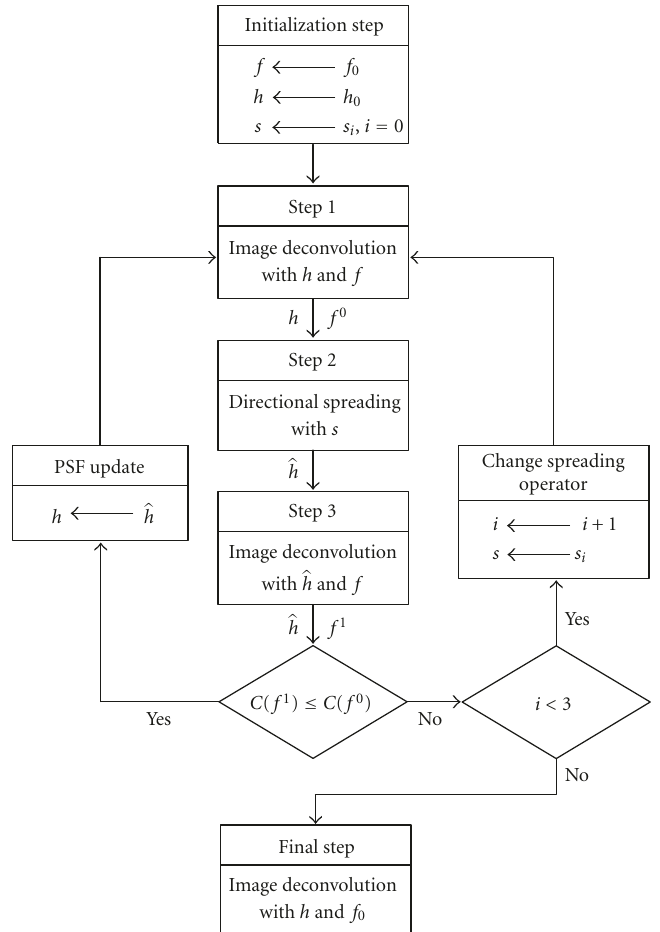
Figure 6: Proposed iterative PSF estimation